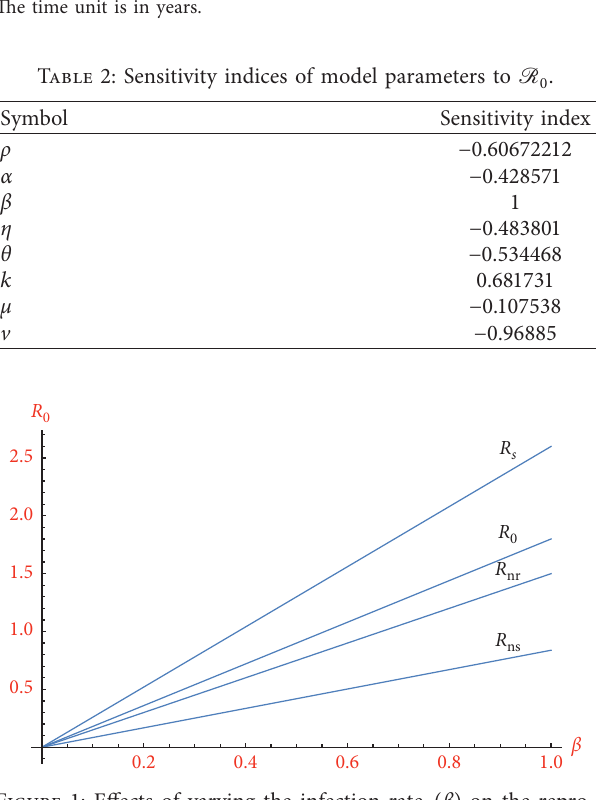
Figure 1: Effects of varying the infection rate ( β ) on the repro- duction